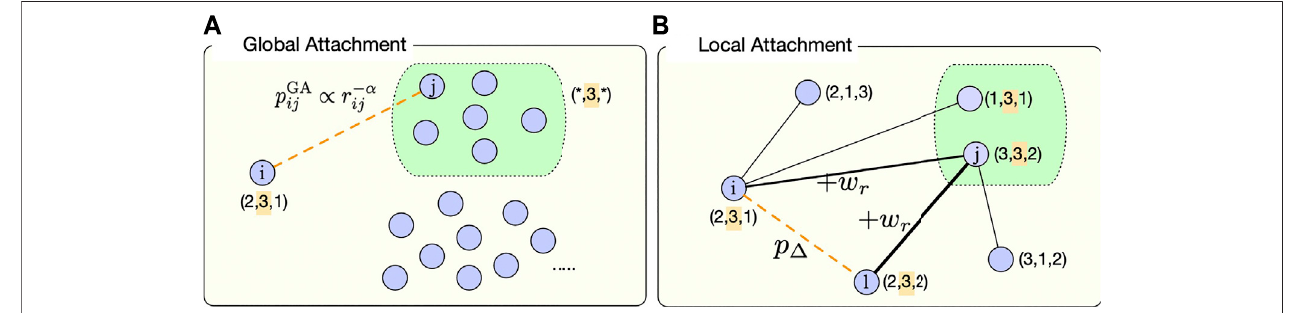
FIGURE 2 | Schematic diagrams of (A) the global attachment (GA) and (B) the local attachment (LA) of the GWSN model. Each node is described by a feature vector,e.g., (cid:1) σ i (cid:1) ( 2 , 3 , 1 ) forthenode i .ForeachupdatebytheGAandLAmechanisms, afeature israndomlychosen,e.g., f (cid:1) 2,thenthenode i interactsonlywithother nodes,say j ,with σ 2 j (cid:1) σ 2 i (cid:1) 3.FortheGAmechanism,thedependenceonthegeographicaldistancebetweennodes, r ij ,iscontrolledbytheparameter α (see Eq.2 ).For the LA mechanism, the triadic closure occurs with the probability p Δ and the involved links increase their weights by w r .